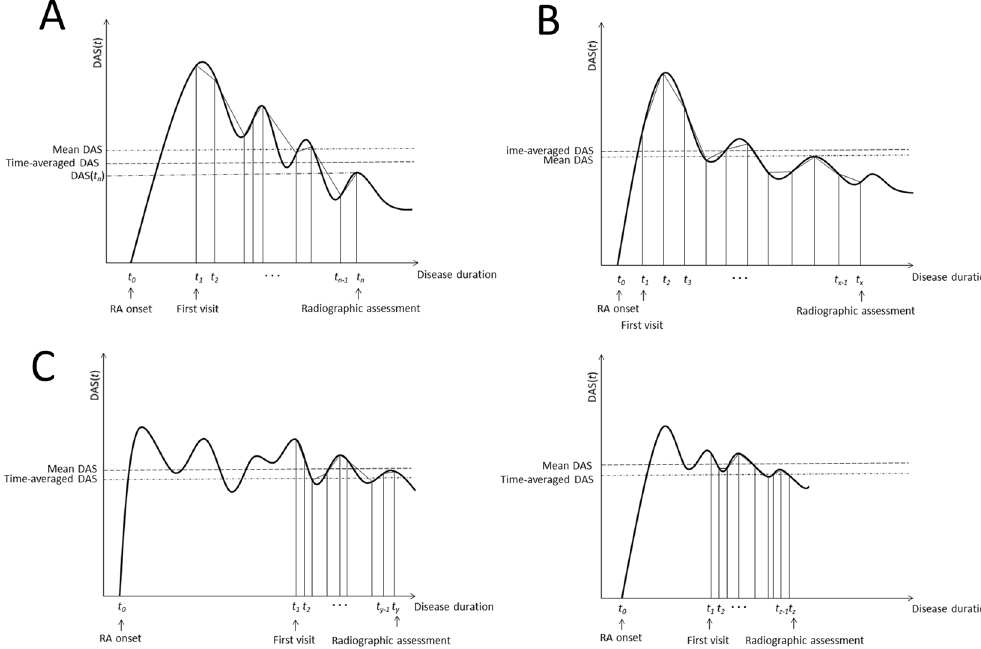
Figure 1. A new model to fit joint destruction in RA. ( A ) Schematic image of calculation of time-averaged DAS. We performed integration of DAS from the first visit to the hospitals to the time for the assessment of SHS, and divided the value by the time. ( B ) Schematic image of ideal cases who start to come to hospital soon after developing RA and are periodically followed-up. ( C ) Schematic image of cases who start to be followed-up later after development of